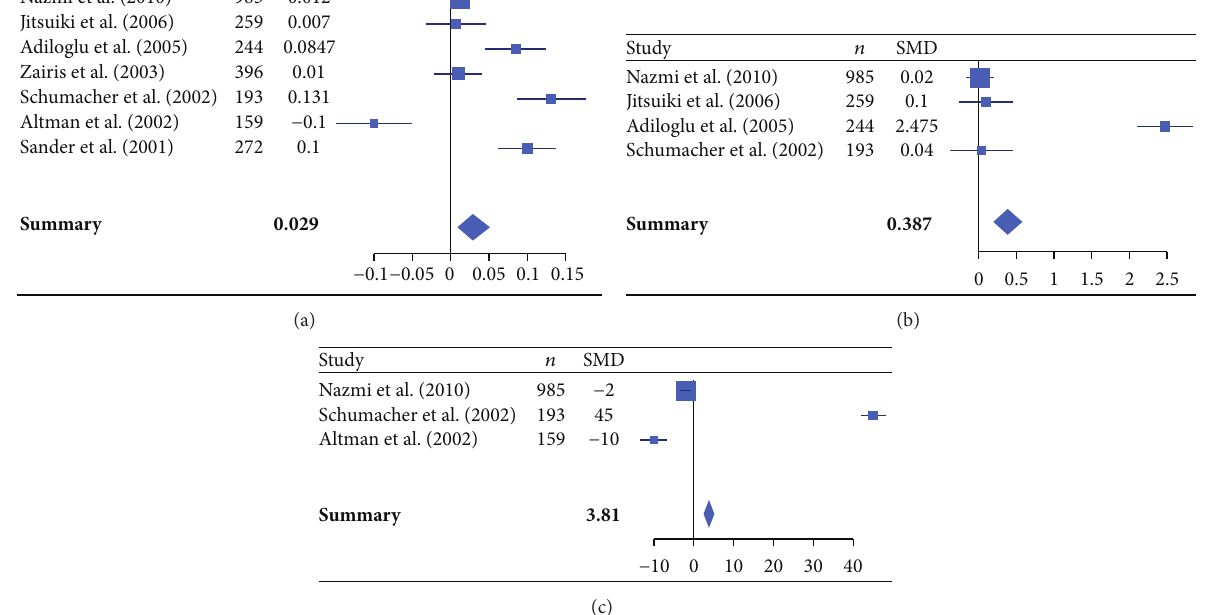
Figure 2: Forest plot of standardized mean differences (SMDs) of individual studies and pooled SMDs for hsCRP (a), IL-6 (b), and fibrinogen (c) in C. pneumoniae IgG seropositive and seronegative patients with atherosclerotic cardiovascular diseases.